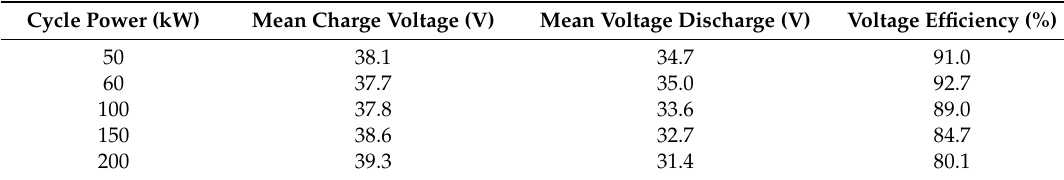
Table 2. Battery voltage efficiency at different power levels.